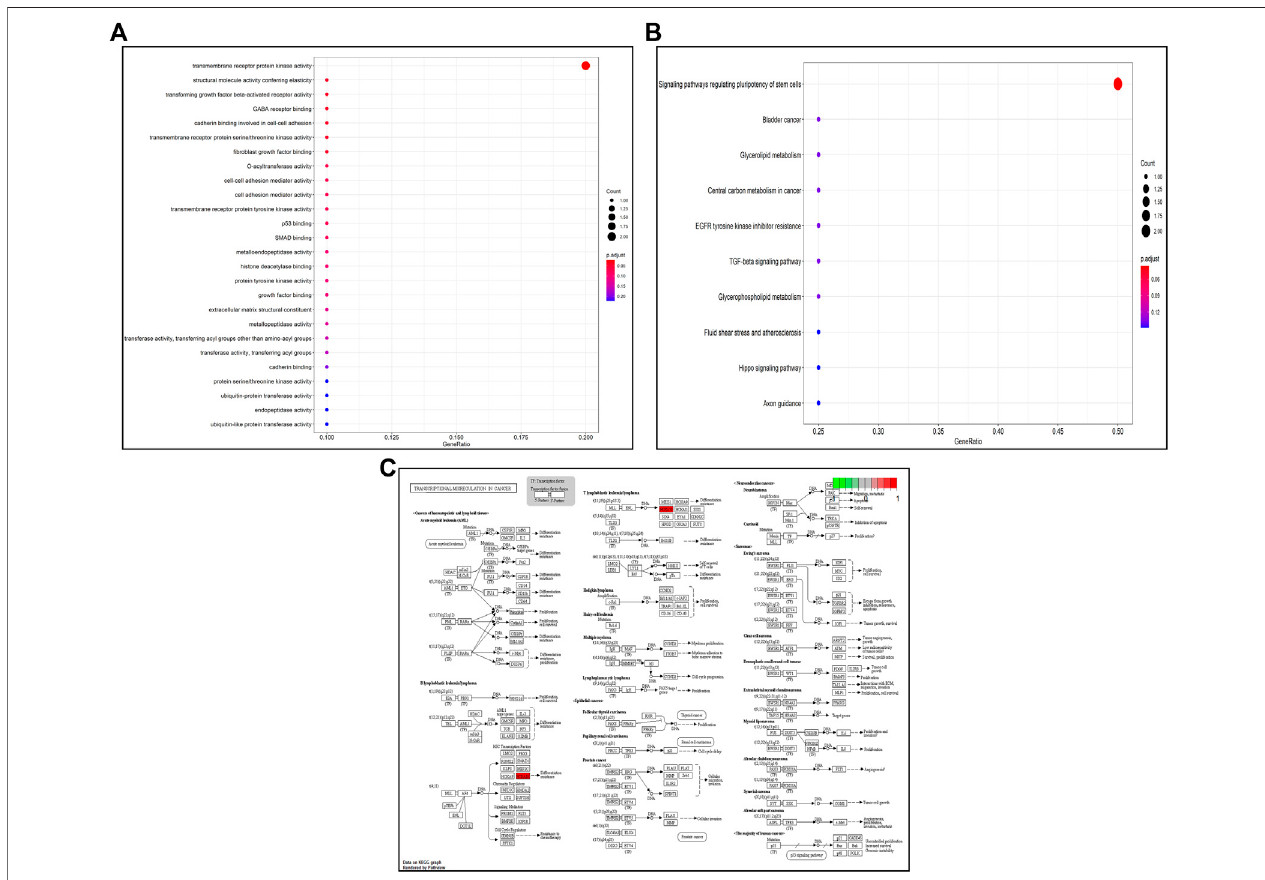
FIGURE 7 | GO/KEGG enrichment analysis: (A) GO enrichment bubble plot of potential target genes. (B) KEGG enrichment bubble plot of potential target genes. (C) Transcriptional dysregulation in cancer signaling pathways.